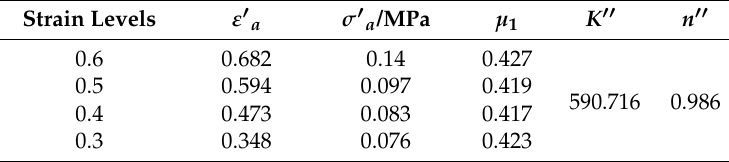
Table 4. Correction parameters of cyclic σ − ε